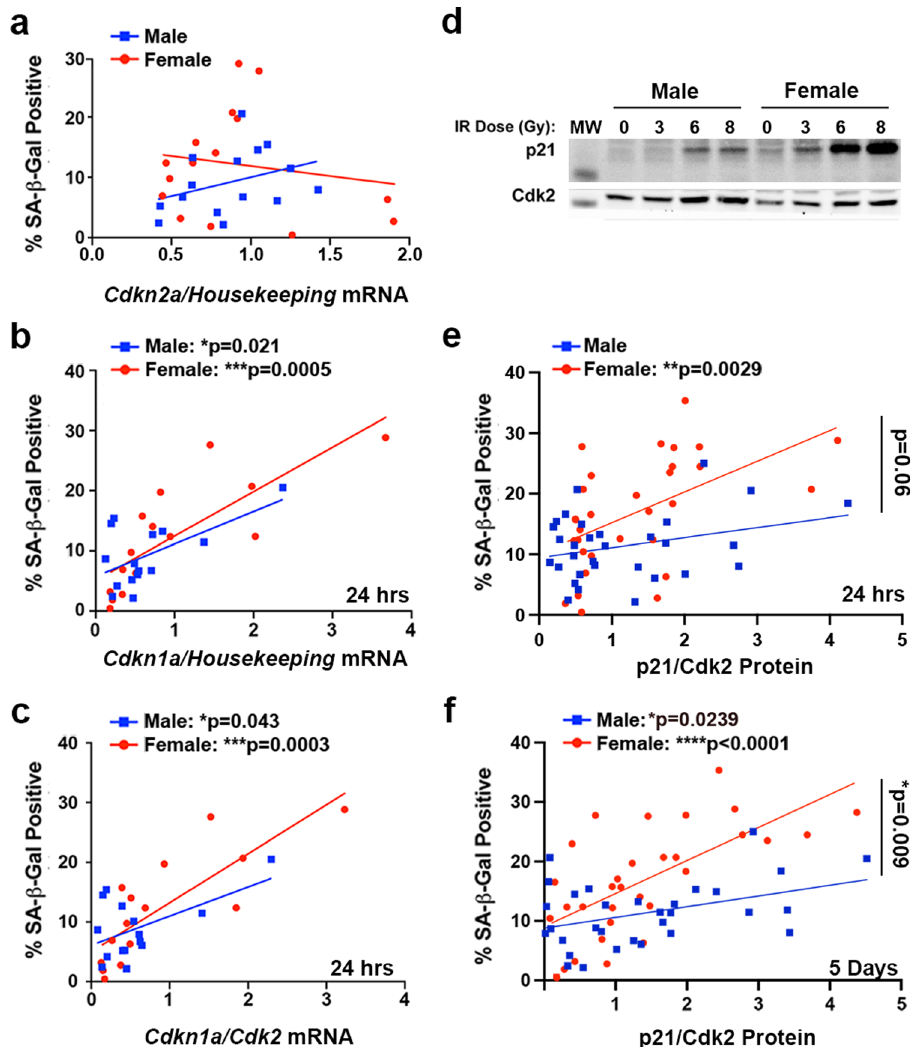
Fig. 4 Expression of p21 differentially correlates with SA- β -gal positivity in male and female mouse GBM model astrocytes. a Correlation between Cdkn2a (p16) mRNA levels at 24 h after irradiation with 0, 6, or 9 Gy and the percentage of SA- β -gal positive cells at 5 days after irradiation in male and female Nf1 − / − DNp53 astrocytes ( n = 15/sex). b Correlation between Cdkn1a (p21) mRNA levels at 24 h after irradiation with 0, 6, or 9 Gy and the percentage of SA- β -gal positive cells at 5 days after irradiation in male and female Nf1 − / − DNp53 astrocytes. Male correlation: r = 0.59, p = 0.0212; Female correlation: r = 0.79, p = 0.0005 ( n = 15/sex). c Correlation between the Cdkn1a/Cdk2 mRNA ratio at 24 h after irradiation with 0, 6, or 9 Gy and the percentage of SA- β -gal positive cells at 5 days after irradiation in male and female Nf1 − / − DNp53 astrocytes. Male correlation: r = 0.53, p = 0.0427; Female correlation: r = 0.80, p = 0.0003 ( n = 15/sex). d Representative western blot images of p21 and Cdk2 5 days post-irradiation with 0, 3, 6, or 8 Gy. One male and one female Nf1 − / − DNp53 cell line are shown. Molecular weight markers (MW): p21 (15 kDa), Cdk2 (30 kDa). e Correlation between the p21/Cdk2 protein ratio at 24 h after irradiation with 0, 3, 6, or 8 Gy and the percentage of SA- β -gal positive cells at 5 days after irradiation in male and female Nf1 − / − DNp53 astrocytes. Male correlation: r = 0.30, p = 0.0997, female correlation: r = 0.52, p = 0.0029, male slope vs female slope: p = 0.0627 — indicated by bracket ( n = 31/sex). f Correlation between the p21/Cdk2 protein ratio 5 days after irradiation with 0, 3, 6, or 8 Gy and the percentage of SA- β -gal positive cells at 5 days after irradiation in male and female Nf1 − / − DNp53 astrocytes. Male correlation: r = 0.40, p = 0.0239, female correlation: r = 0.65, p < 0.0001, male slope vs female slope: p = 0.009 — indicated by bracket ( n = with the percentage of SA- β -gal positive cells in both males ( r = 0.40, p = 0.0239) and females ( r = 0.65, P < 0.0001), it was with signi fi cantly different slopes ( p = 0.009) (Fig. 4f, Supple- mentary Table 3). Thus, the same level of p21/Cdk2 expression at 5 days corresponded to higher levels of senescence in females than in males, as measured by SA- β -gal. This suggests that not only does the p21/Cdk2 ratio play a role in the maintenance of senescence following irradiation, but that there may be a sex difference in sensitivity to p21/Cdk2 levels and/or that p21 may be playing a greater role in irradiation-induced senescence in female GBM cells than in male GBM cells.